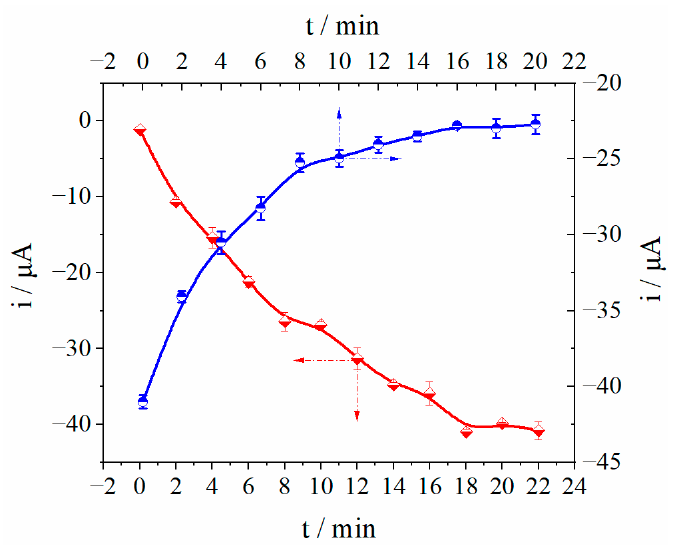
Figure 3. Optimization of elution time ( a ) and rebound time ( b ).